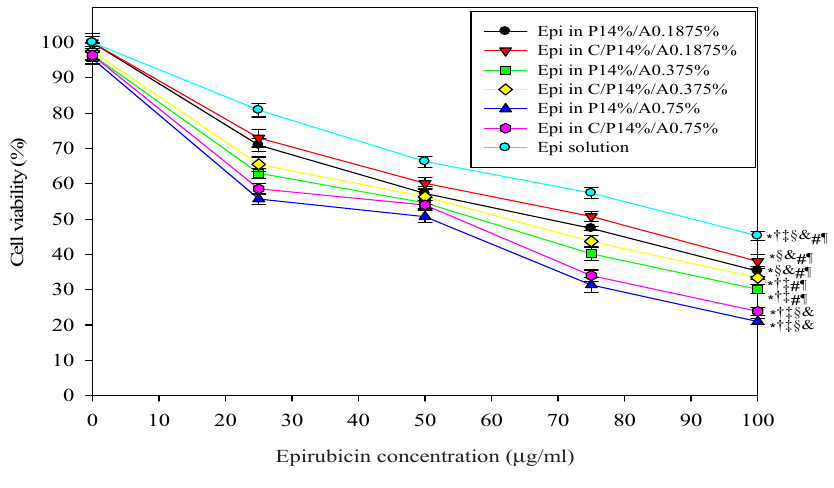
Figure 2. In vitro cytotoxic effects of Epi in liquid and solid suppositories on CT26 cells. These suppositories consist of different Plu/PAA ratios with various Epi concentrations at 0, 25, 50, 75, and 100 μ g/mL. C represents cocoa butter; P for Plu; A for PAA. * p < 0.05 compared with Epi solution; † p < 0.05 compared with Epi in P14%/A0.1875%; ‡ p < 0.05 compared with Epi in C/P14%/A0.1875%; § p < 0.05 compared with Epi in P14%/A0.375%;